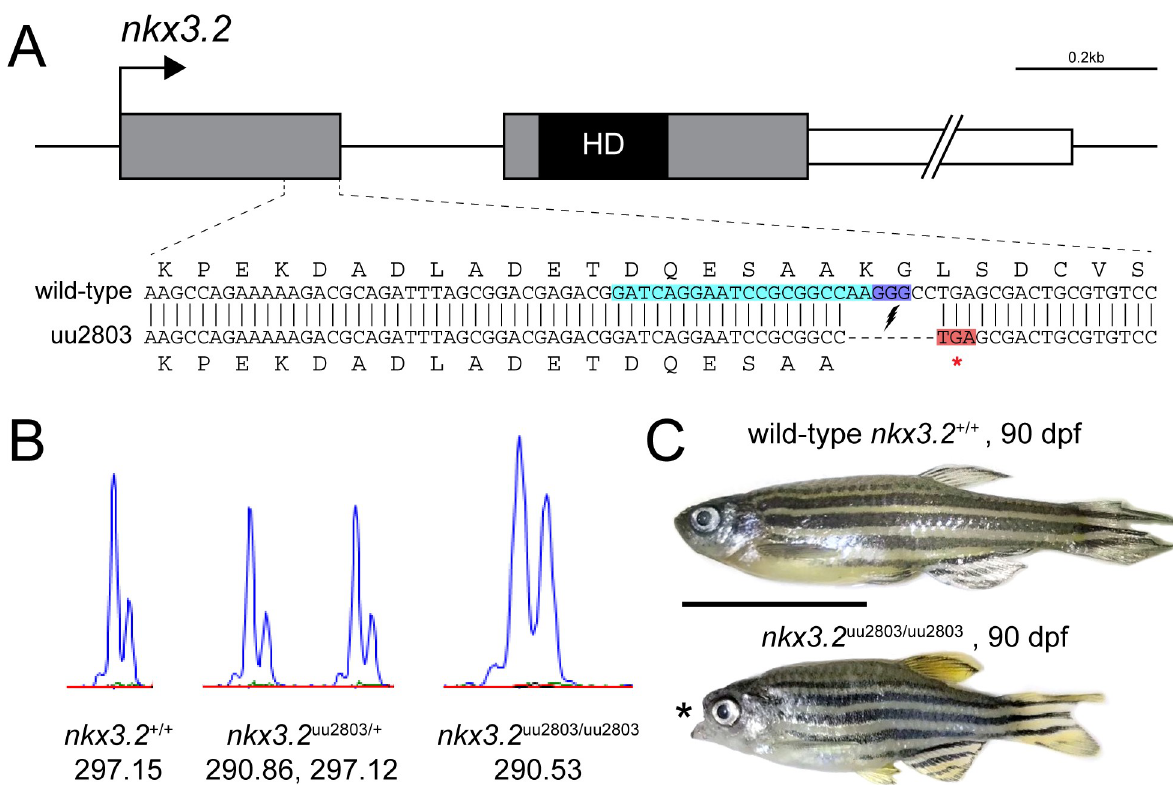
Fig 1. Zebrafish nkx3 . 2 null allele generated with CRISPR/Cas9. ( A ) To-scale schematic of the two-exon zebrafish nkx3 . 2 gene locus on chromosome 14. Grey boxes represent the coding sequence, the black box labelled “HD” marks the location of the homeodomain-coding sequence in the second exon, and the white box marks the 1,226bp 3’ UTR, truncated for illustrative purposes. gRNA target site is marked by turquoise background. The sequence of the zoomed in section of exon 1 shows the alignment between the wild-type and mutant (uu2803) alleles. The mutant allele has a 7 base-pair deletion that results in a frameshift and a premature stop codon (highlighted in red) immediately after the deletion site. ( B ) Wild-type, heterozygous nkx3 . 2 uu2803/+ and homozygous nkx3 . 2 uu2803/uu2803 fish were genotyped by fragment length analysis. The wild-type displayed one peak (297,15), nkx3 . 2 uu2803/+ fish one wild-type (297,12) and one mutant (290,86) peak and nkx3 . 2 uu2803/uu2803 fish one mutant peak (290,53). ( C ) nkx3 . 2 uu2803/uu2803 fish at 90 dpf display a prominent fixed open mouth phenotype compared to wild-type at 90 dpf. Scale bars: 1